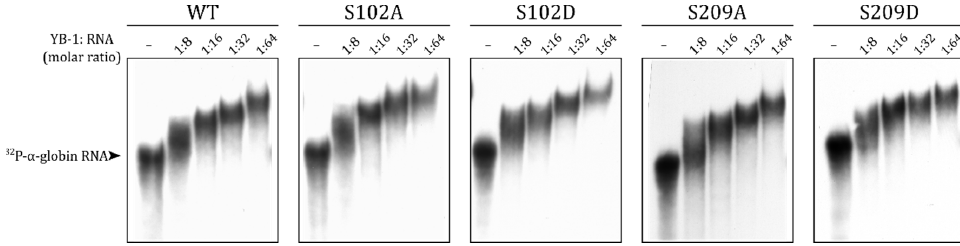
Figure 4. S102 and S209 phosphomimetic substitutions do not affect the YB-1-to-RNA binding. WT and mutant YB-1 binding to nonspecific [ 32 P]-labeled 660-nt α -globin RNA was analyzed with